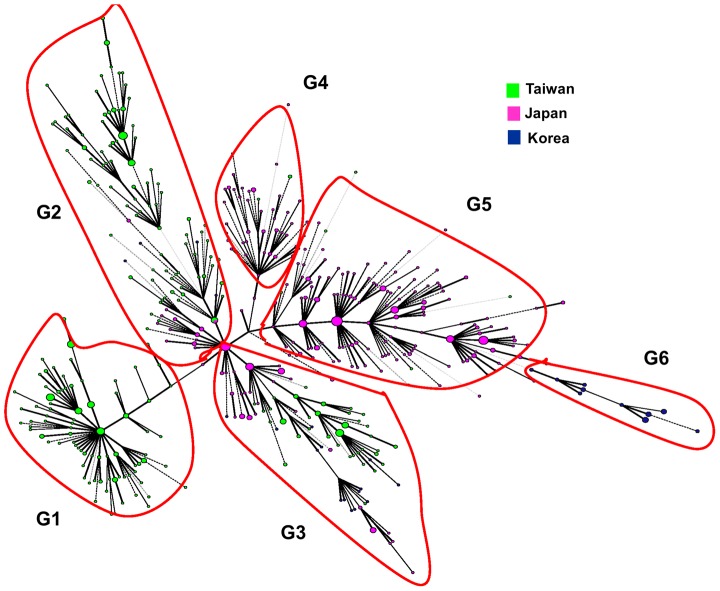
A minimum spanning tree based on 21–MIRU-VNTR genotyping of MTB isolates from Taiwan, Japan, and South Korea.The sizes of the branches correspond to the number of isolates with a particular genotype. Each country is assigned a different color. MTB isolates from Taiwan, Japan, and South Korea are colored green, pink, and blue, respectively.